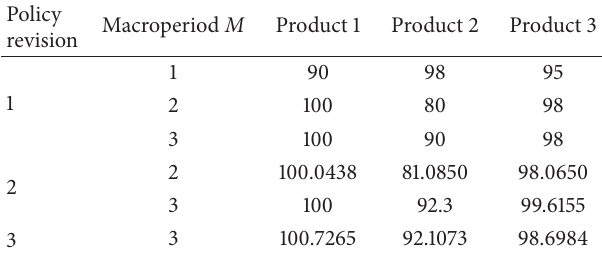
Table 4: Updates of the product demand expectations during the process of policy revision.